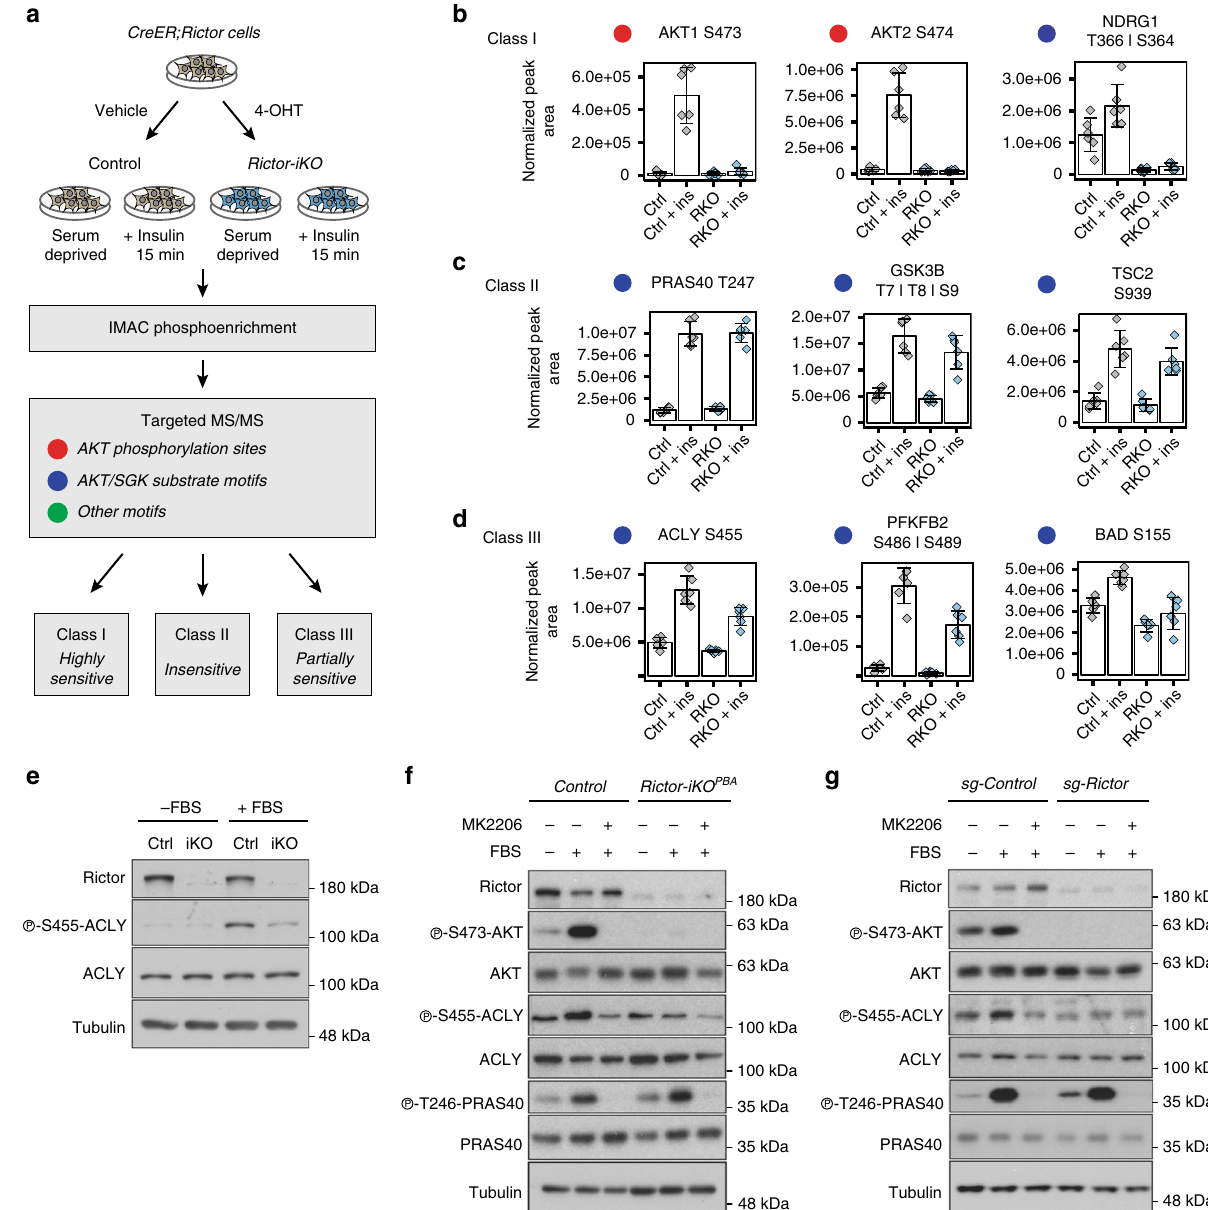
Fig. 1 Identi fi cation of mTORC2-sensitive phosphorylation sites, including S455 in ATP citrate lyase (ACLY). a Phosphoproteomics work fl ow and analysis in Rictor-iKO PBAs . Colored circles correspond with the type of motifs analyzed ( n = 6 per group). b , c Motifs were strati fi ed by their sensitivity to mTORC2 loss as being highly sensitive Class I sites ( b ), insensitive Class II sites ( c ), or partially sensitive Class III sites ( d ). e Western blots of protein lysates from control and Rictor-iKO PBA cells using the indicated total and phospho-speci fi c antibodies. Cells growing in DMEM were either serum deprived ( − FBS) or serum deprived and then stimulated with fresh serum for 15 min ( + FBS) prior to lysis. f Western blots of protein lysates treated as in e with or without the AKT inhibitor MK2206. g Western blots using lysates from HEK293 cells in which Rictor was deleted by CRISPR/Cas9 genome editing. The AKT inhibitor MK2206 (10 μ M) was administered 1 h prior to lysis in both f and g NDRG1 protein levels as measured by mass spectrometry.